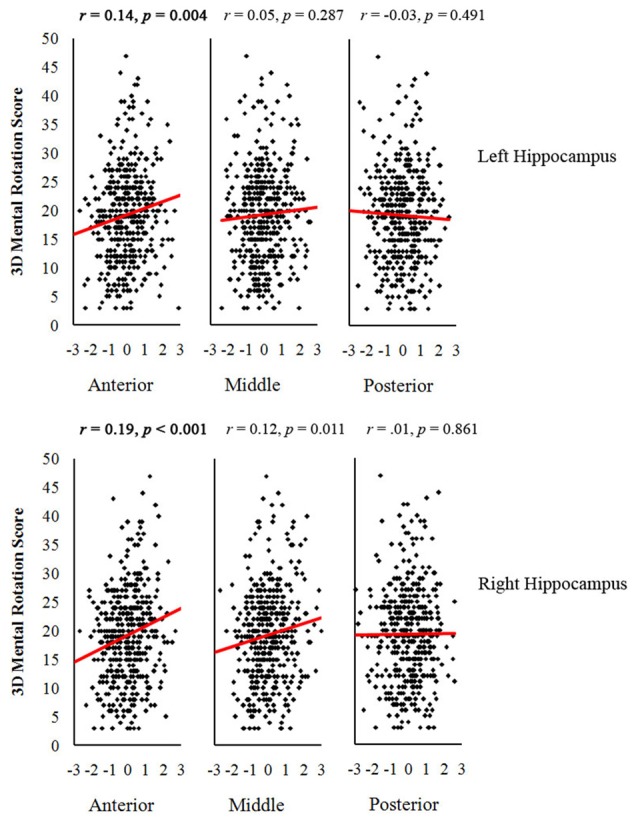
Scatter plots between gray matter volumes (GMV) of anterior, middle and posterior hippocampus and 3-dimensional (3D) mental rotation performance (with the GMV of the whole brain as a covariate). The critical p value after Bonferroni correction was 0.008 (0.05/6 ROIs). Significant p values are in bold.